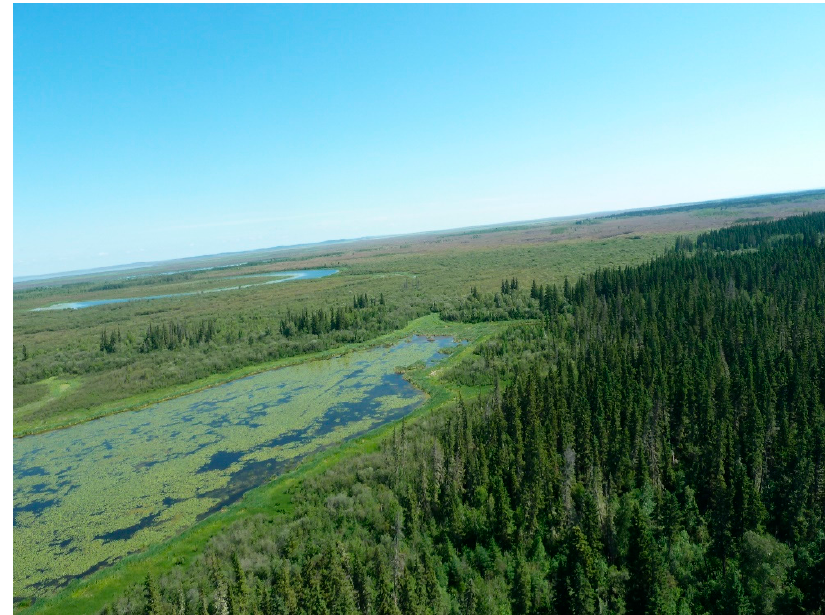
Figure 2. Wetland complex within the Athabasca Delta looking northeast from the Embarras River forested levee towards Mamawi Lake. Photo taken by Environment and Climate Change Canada in July 2017. See Figures 1 or 3 for location of photo within study area.